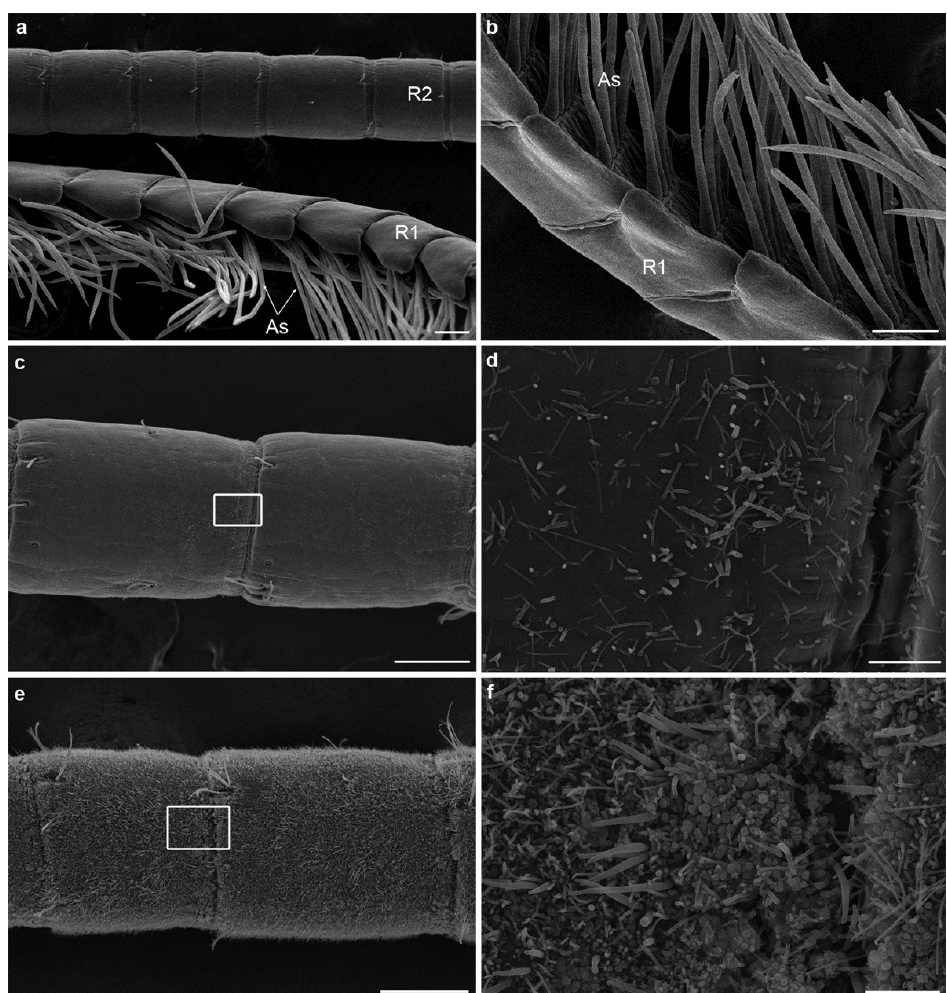
Figure 7. Scanning electron micrographs of Palaemon serratus (juveniles) before (Ps1, Ps2) and after (Ps10, Ps11) grooming experiments. ( a , c , e ) Antennules of Ps10 ( a ), Ps1 ( c ) and Ps2 ( e ) specimens showing gradation from absent ( a ), to moderate ( c ) and intense ( e ) bacterial fouling on the antennal segments. ( a ) Antennules of Ps10 specimen, showing the two ramus and the aesthetascs completely devoid of bacterial fouling; ( b ) close-up on the aesthetascs of Ps11 specimen completely devoid of bacterial fouling; ( c , d ) antennae of Ps1 specimen with a light fouling of bacteria. Frame in ( c ) is enlarged in d showing the bacterial morphological variety, with thick and thin filamentous bacteria, some rods and cocci; ( e , f ) antennules of Ps2 specimen with very dense fouling covering the entire surface of the segments. Frame in ( e ) is enlarged in ( f ), showing bacterial density and morphological diversity. As: aesthetascs, R1 and R2: the two rami of the lateral antennular flagellum. Scale bars: ( a , b , c , e ) = 100 μ m; ( d , f ) = 10 μ m.